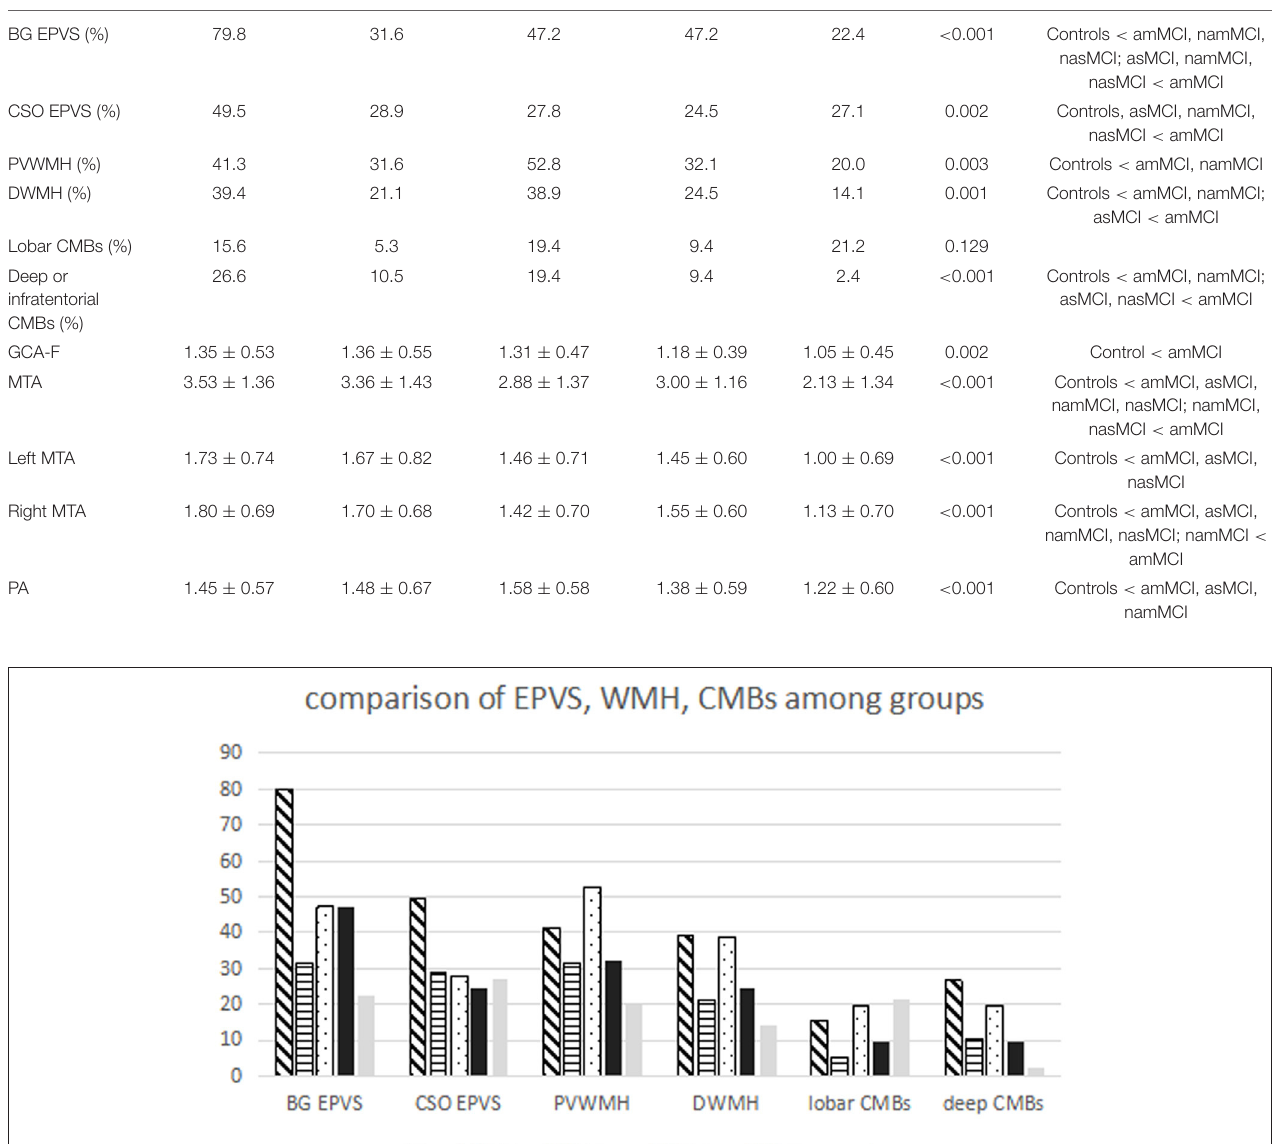
Patients with aMCI had obvious memory impairments than naMCI and controls on all memory tests. There were heterogeneous results on different tests of other